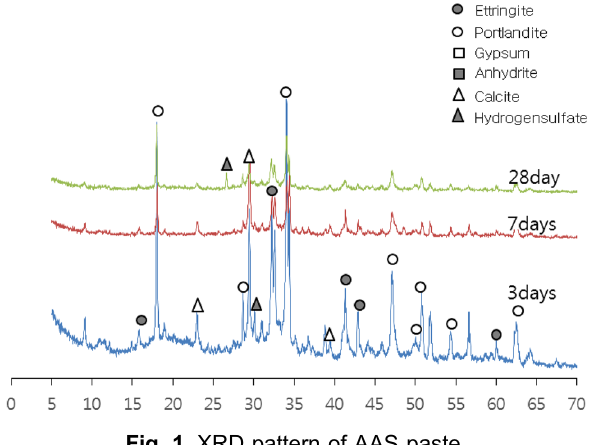
Fig. 1 XRD pattern of AAS